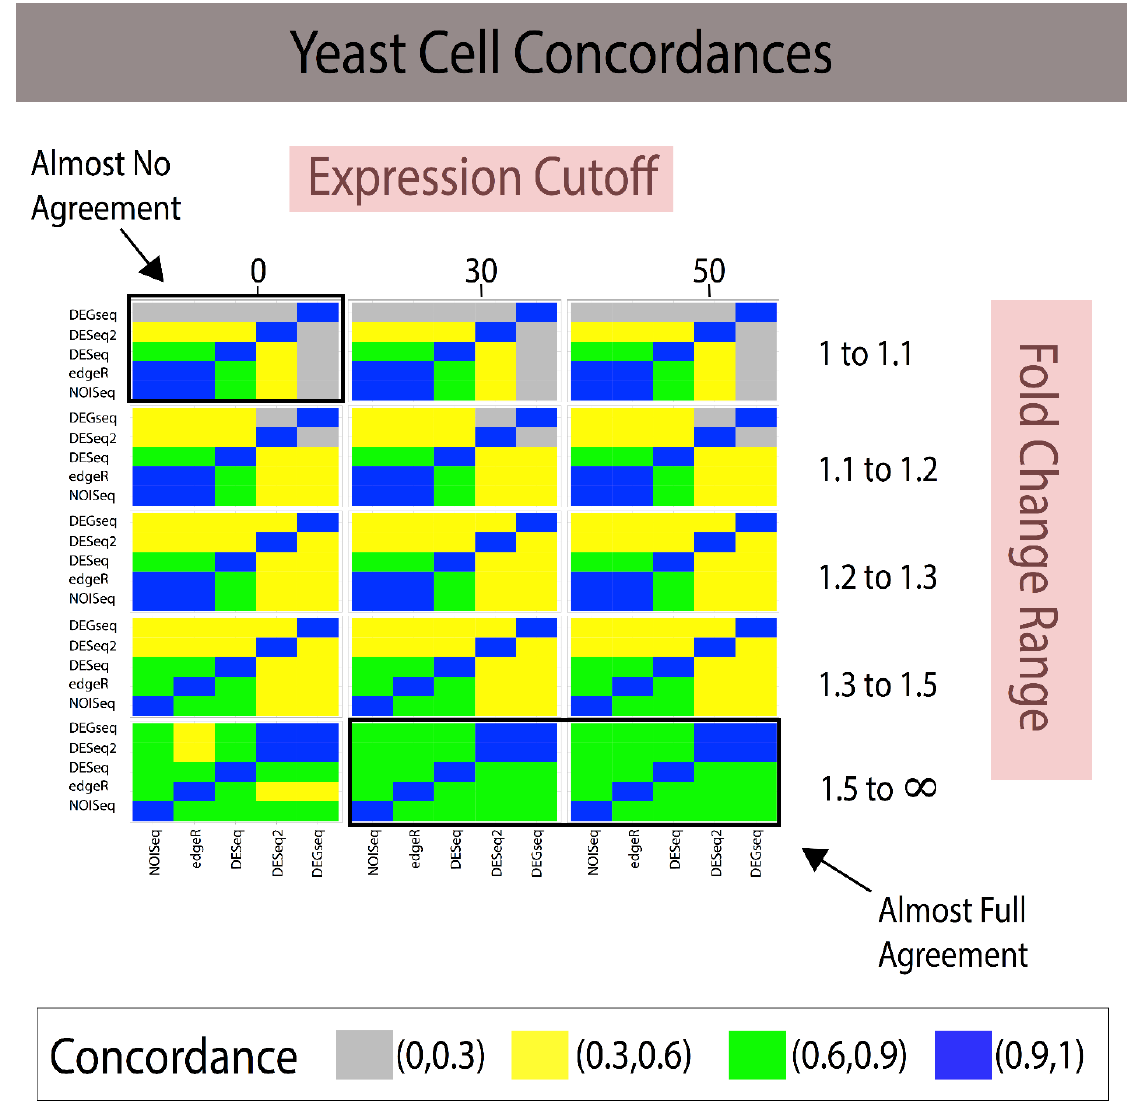
Figure 3. Combining fold change and expression level filtering leads to robust, method-agnostic reference standards for single-subject studies in yeast. The grid of heatmaps illustrates that as low-expression genes with small fold changes across individuals are filtered out, the reference standards constructed provide higher concordance with one another. Given the larger number of replicates in yeast, it may be that less rigid filters are required to produce reliable, concordant reference standards. Expression cutoffs in average counts across samples. White cells indicate that no predictions were made, and therefore the Jaccard Index cannot be calculated. Note: When the Jaccard Index cannot be calculated due to the lack of transcripts, the color of the rectangle is white; in addition, FC ranges are symmetrical 1/1.1 to 1 and 1–1.1, 1/1.2–1 and 1–1.2, etc. (Legend: In the manuscript and figure, we represent FC for upregulated genes and 1/FC for downregulated genes.”).